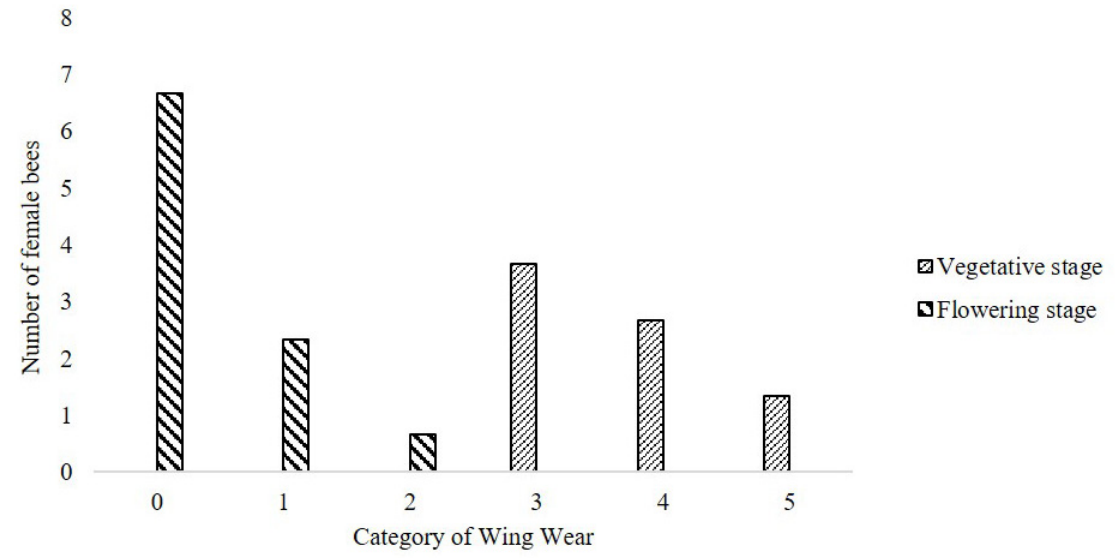
Fig 5 . Classification of foraging female of leaf cutter bees Megachile Latreille, 1802 as per wing wear in studied specimens from the experimental farm of ICAR-National Bureau of Agricultural Insect Resources (NBAIR) Bengaluru, Yelahanka Campus, India. Diversity of leafcutter bees ( Megachile spp.)